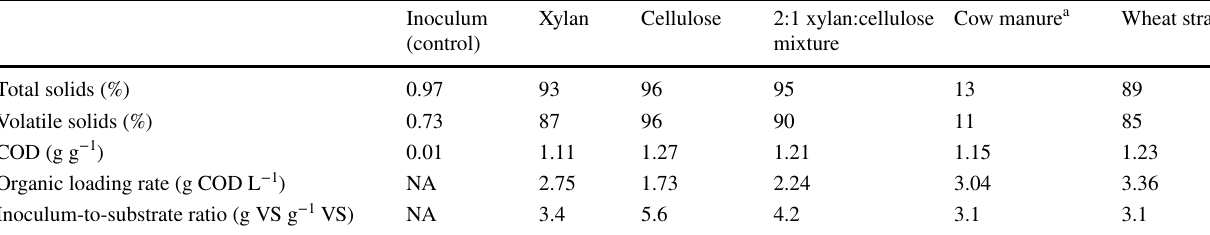
Table 1 Physicochemical characteristics of the inoculum and